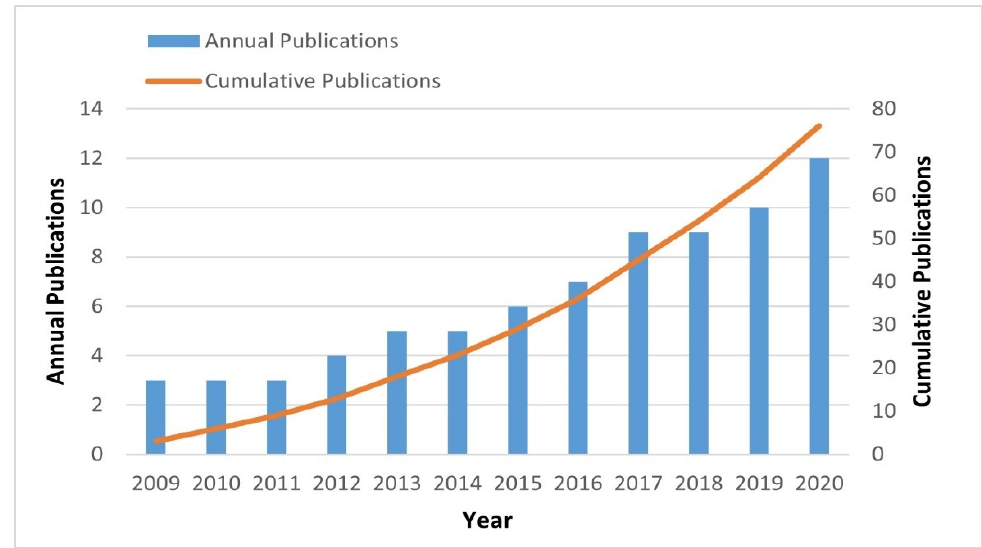
Figure 2. PRISMA protocol to extract empirical articles for this systematic study.